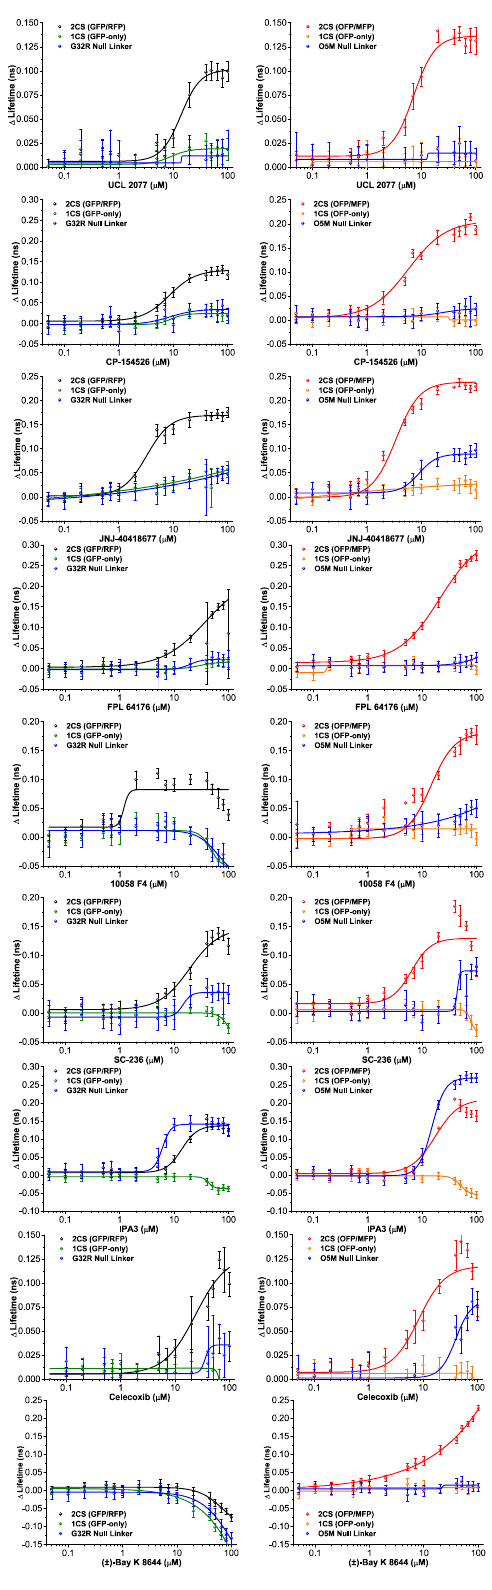
Figure A2. LOPAC hit concentration-response curves (CRC). Concentration-dependent FRET changes are plotted for all nine overlapping 2CS FRET hits. The left panel shows the ∆ lifetime CRCs from 2CS (G/R) FRET biosensor ( black ) and the control cell lines from the GFP-only ( green ) and GFP/RFP G32R null linker ( blue ). The right side of the figure panel shows the ∆ lifetime CRCs from 2CS (O/M) FRET biosensor ( red ) and the control cell lines from the GFP-only ( orange ) and OFP/MFP O5M null linker ( blue